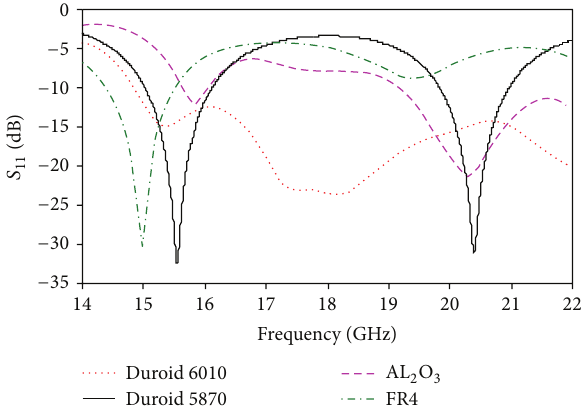
Figure 13: Simulated return loss with different substrate materials.